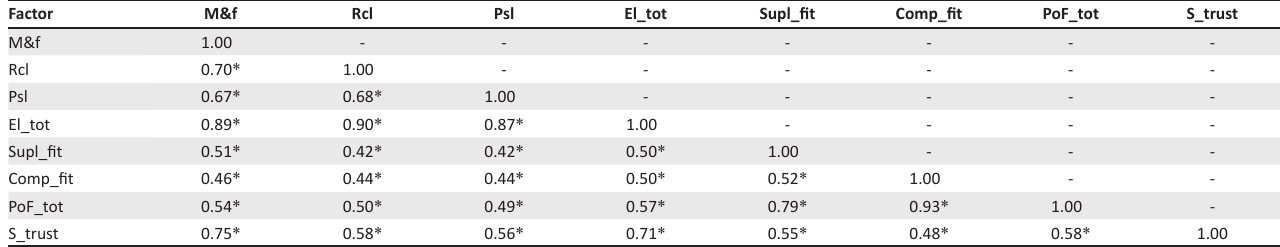
TABLE 2: Correlation matrix of the factors of ethical leadership, P-O fit and supervisory trust. Factor